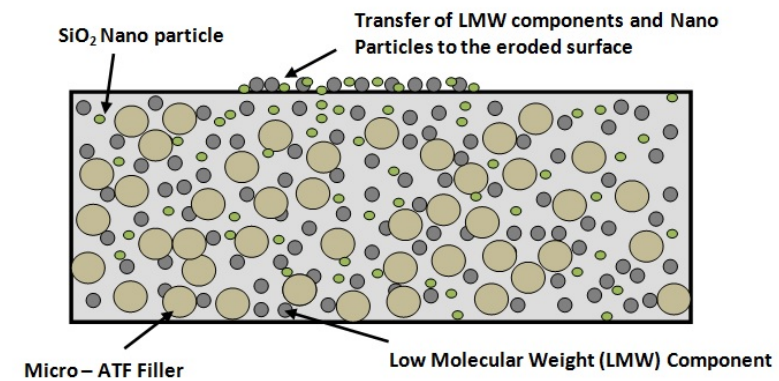
Figure 9. Schematic illustration of the transfer of the LMW components and the nanoparticles to the eroded surface.